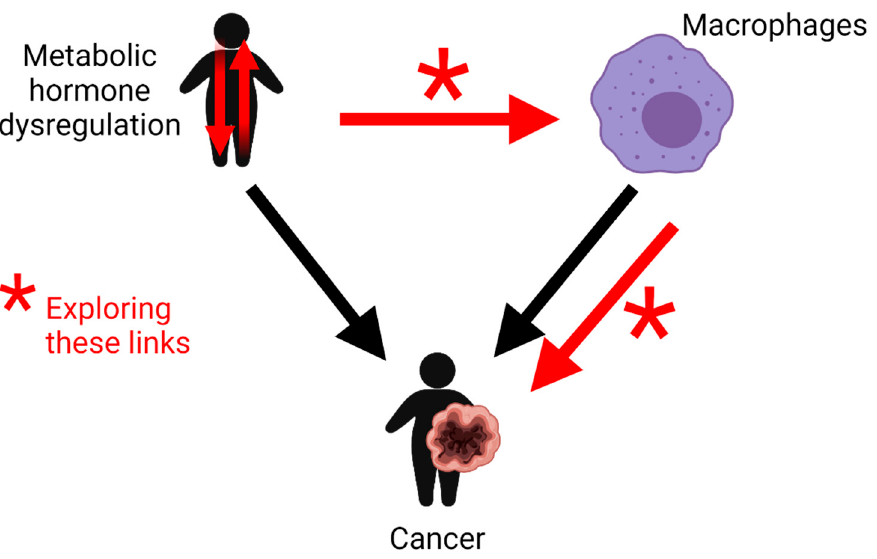
Figure 2. Schematic illustrating the links this review will explore (red arrows) between potential metabolic hormone dysregulation, macrophage inflammatory responses and cancer development. This figure was created with Biorender.com.